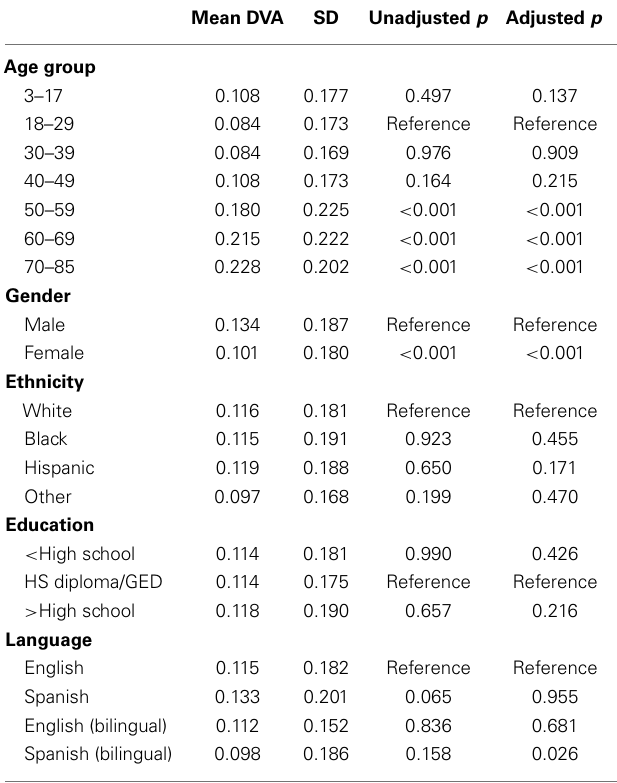
Table 3 | Mean DVA score stratified by sociodemographic characteristics .